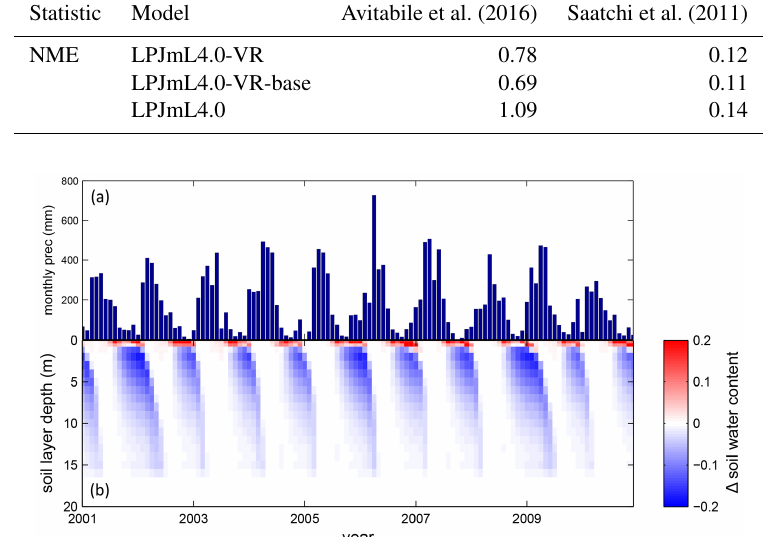
Table B5. Normalized mean error (NME) of AGB comparison piecewise calculated between (1) the satellite-derived AGB validation products and (2) all LPJmL model versions used in this study forced with CRU climate data (in accordance with Fig. B10).